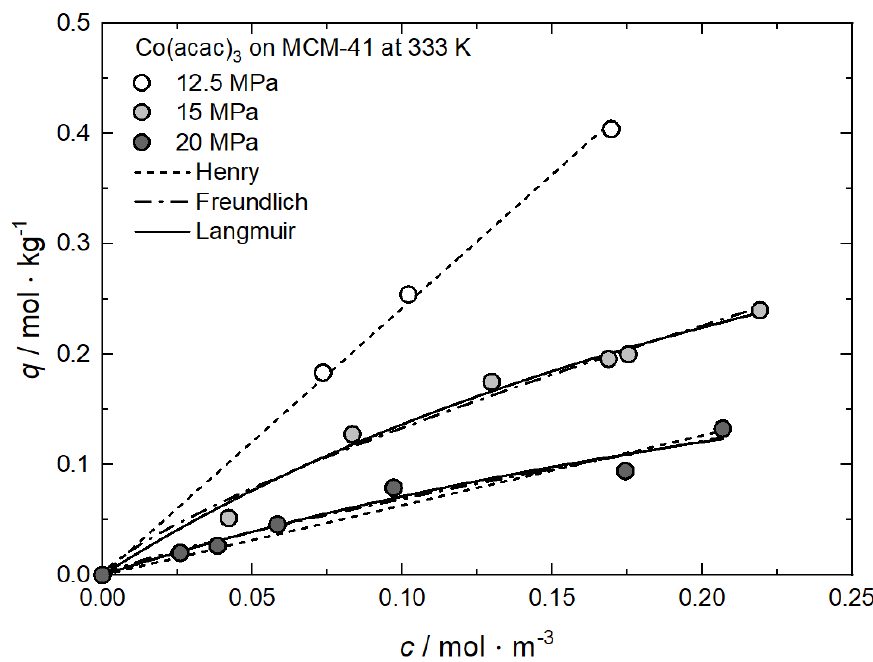
Figure 8. Uptake of Co(acac) 3 on MCM-41 at 333 K and different pressures; experimental data taken from [60].